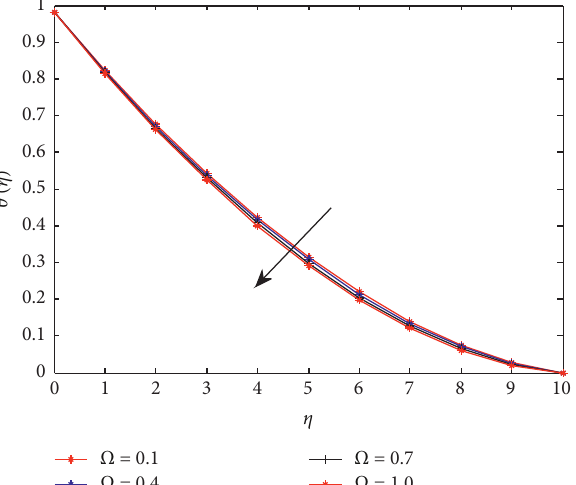
Figure 9: Variation in temperature against various values of Ω when Pr � 0 . 72 ,M � λ � R � s � 1, c � 0 . 2, β � 0 . 2, and Ec � 0 .